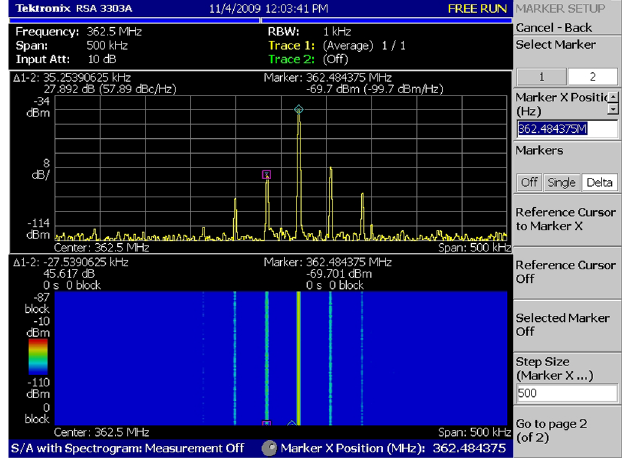
FIG. 3. Positron spectrum in collision (before) and off colli- sion (after).